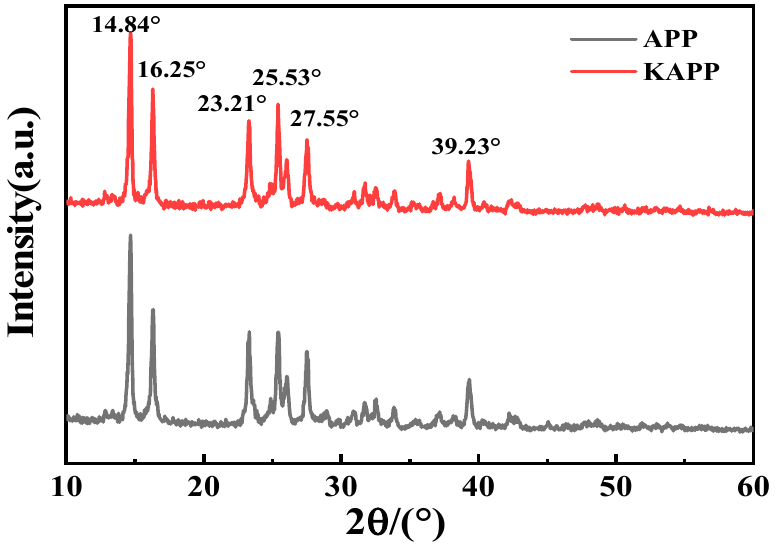
Figure 6. XRD pattern of APP and KAPP.